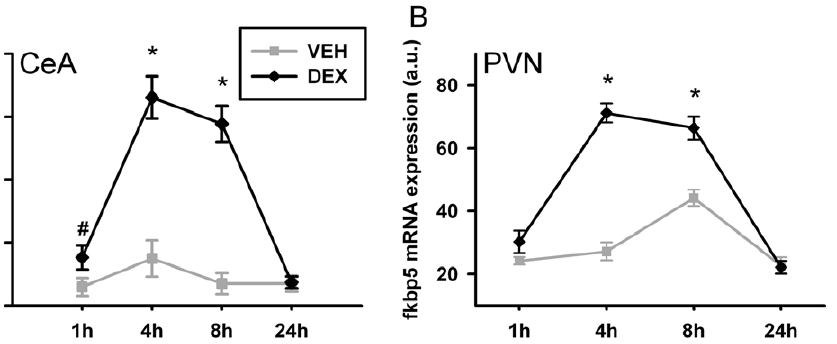
Figure 5. Temporal regulation of fkbp5 mRNA in the central amygdala and the hypothalamic PVN following dexamethasone injection. ( A ) Fkbp5 mRNA was significantly upregulated 4 h and 8 h after dexamethasone treatment in the central amygdala, but returned to baseline after 24 h. Upregulation can already be detected 1 h after injection as a trend. ( B ) The same holds true for the hypothalamic PVN. In addition, an effect of the vehicle injection can be seen with an increase after 8 h. VEH = injected with vehicle, DEX = injected with dexamethasone, CeA = central amygdala, PVN = paraventricular nucleus. Data are given in mean 6 SEM. * different to vehicle p , 0.05, # different to vehicle p , 0.1. doi:10.1371/journal.pone.0016883.g005 PLoS ONE |